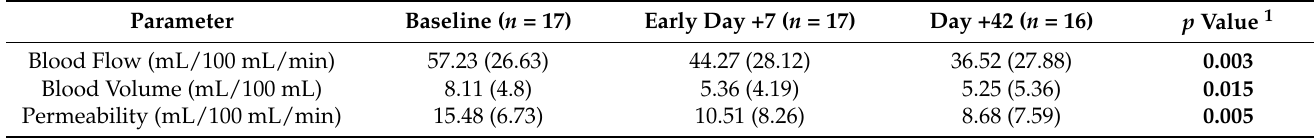
Table 3. Changes in perfusion parameters from baseline values. Mean values are shown, with the standard deviation in parentheses.